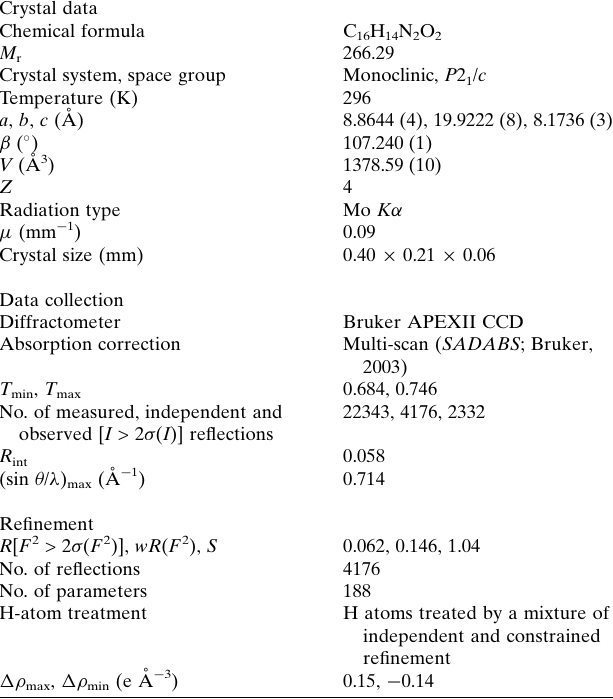
Table 3 Experimental details. Crystal data Chemical